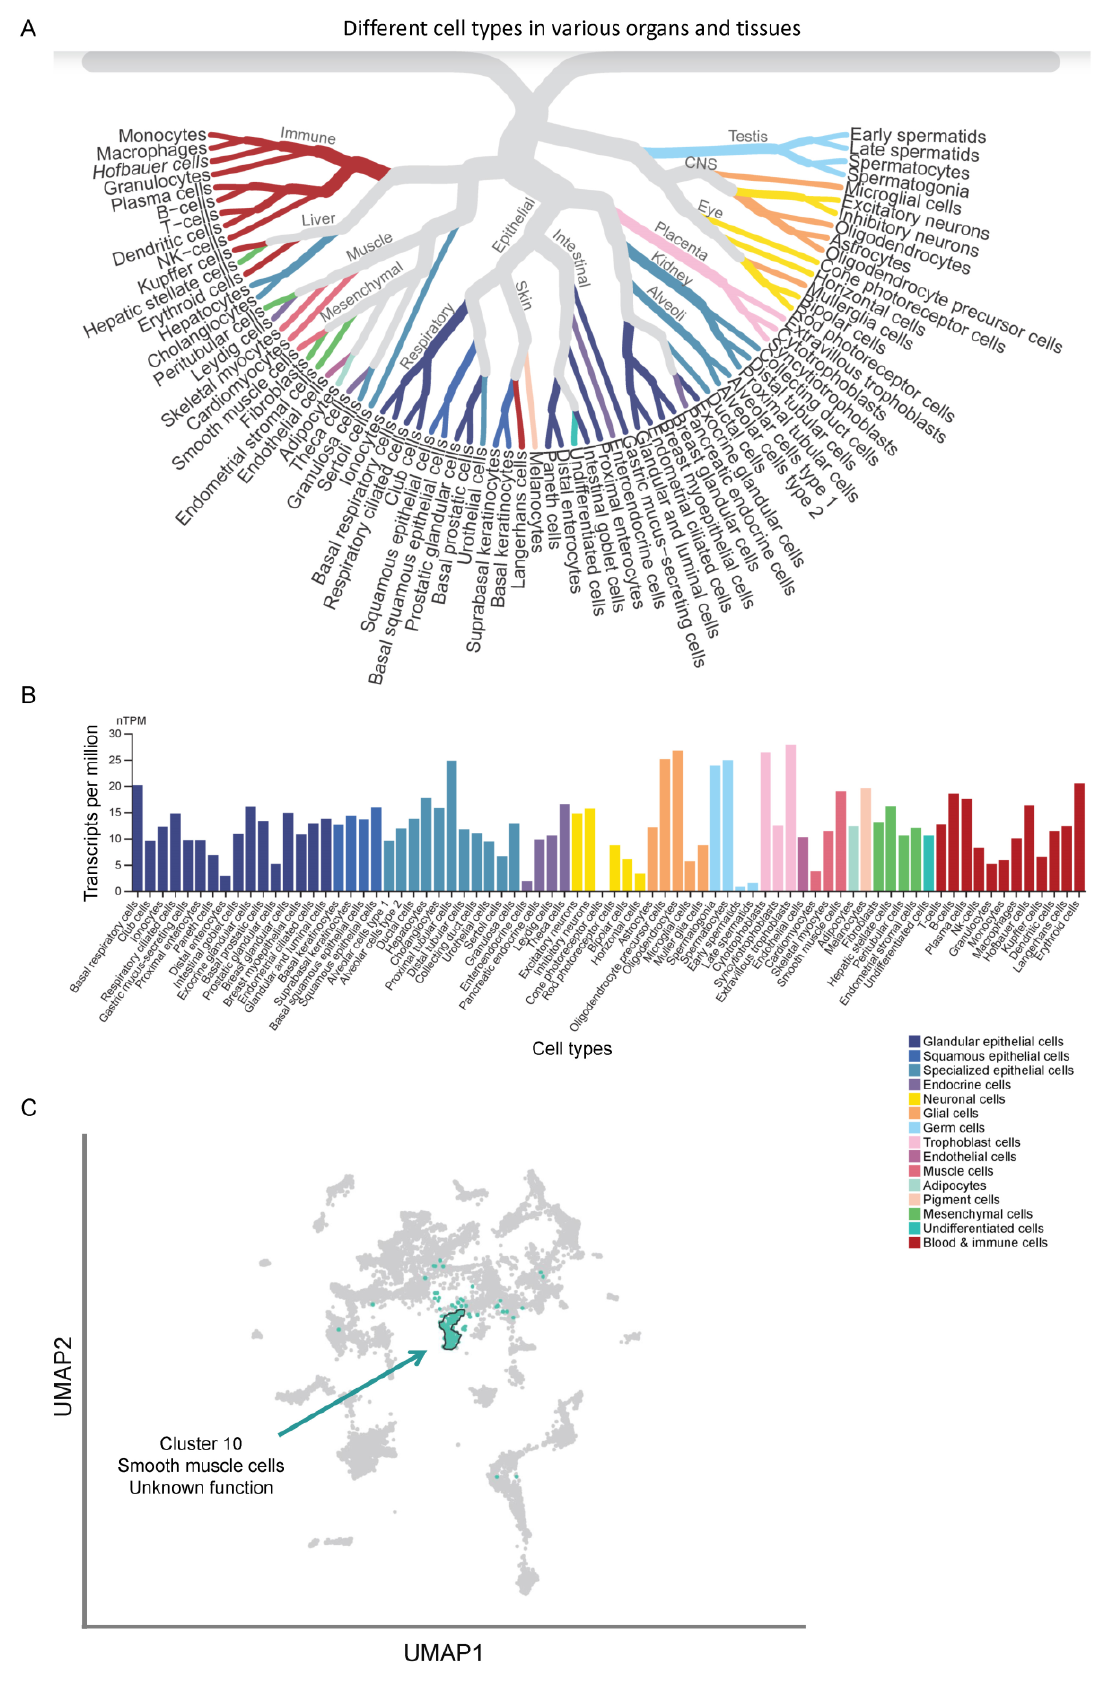
Figure 1. The single cell RNA sequencing identifies the expression pattern of FBXO4 in different cells (www.proteinatlas.org (accessed on 1 March 2022)). ( A ) The schematic illustration demonstrates